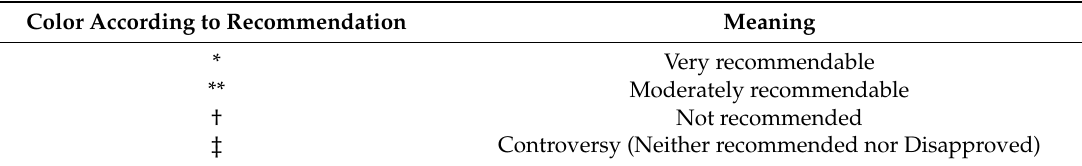
Table 2. Grade of recommendation according to the Oxford Center for Evidence-based Medicine Levels of Evidence (May